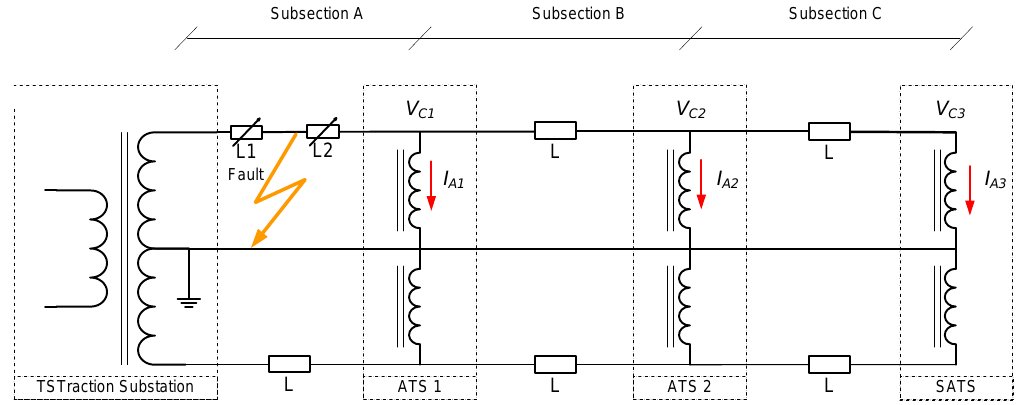
Figure 12. Laboratory circuit to simulate a section fed by a 2 × 25 kV system with two conductors and ground return. A fault between the catenary and rail in subsection A is represented.